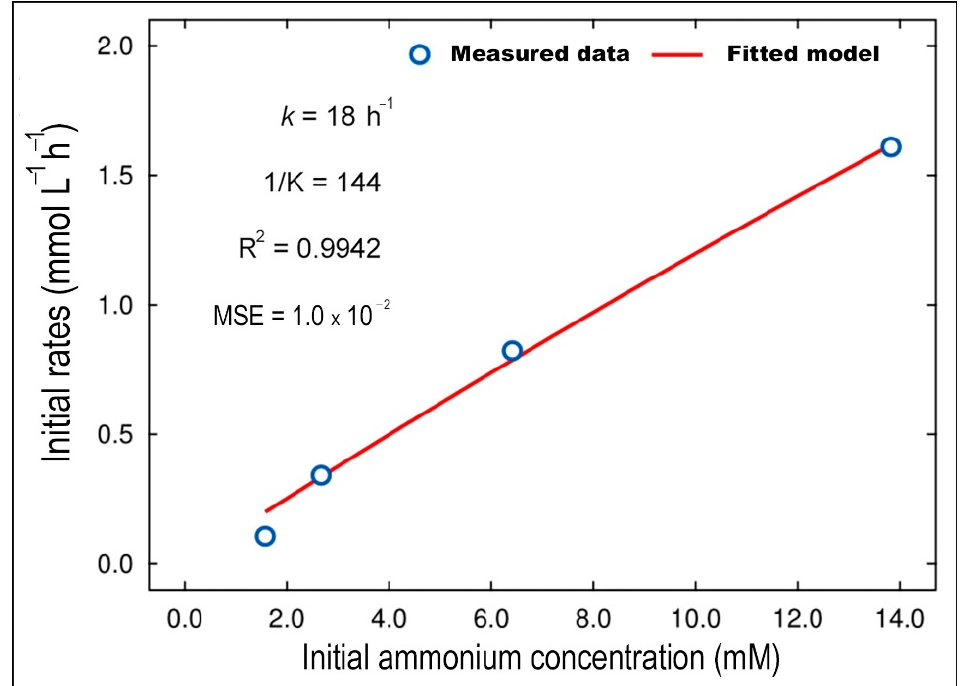
Figure 8. Fit to the Langmuir–Hinshelwood differential equation of the initial rate versus initial concentration data for ammonia removal photocatalytic process at pH = 11.0, P = 25 W, Q = 1000 L/h, temperature = 20 ± 1 °C.